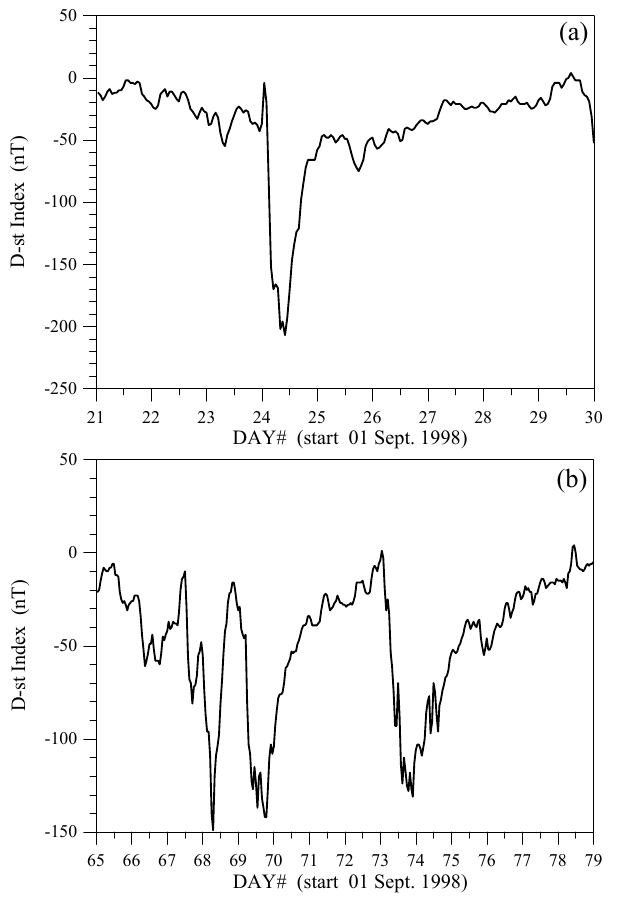
Fig. 13. Amplitude spectra of the geomagnetic A p -index (upper plot) and of the residual of hm F2 (bottom) in the period range 4– 70h obtained by the correloperiodogram analysis. The 95% confi- dence level is shown by dashed